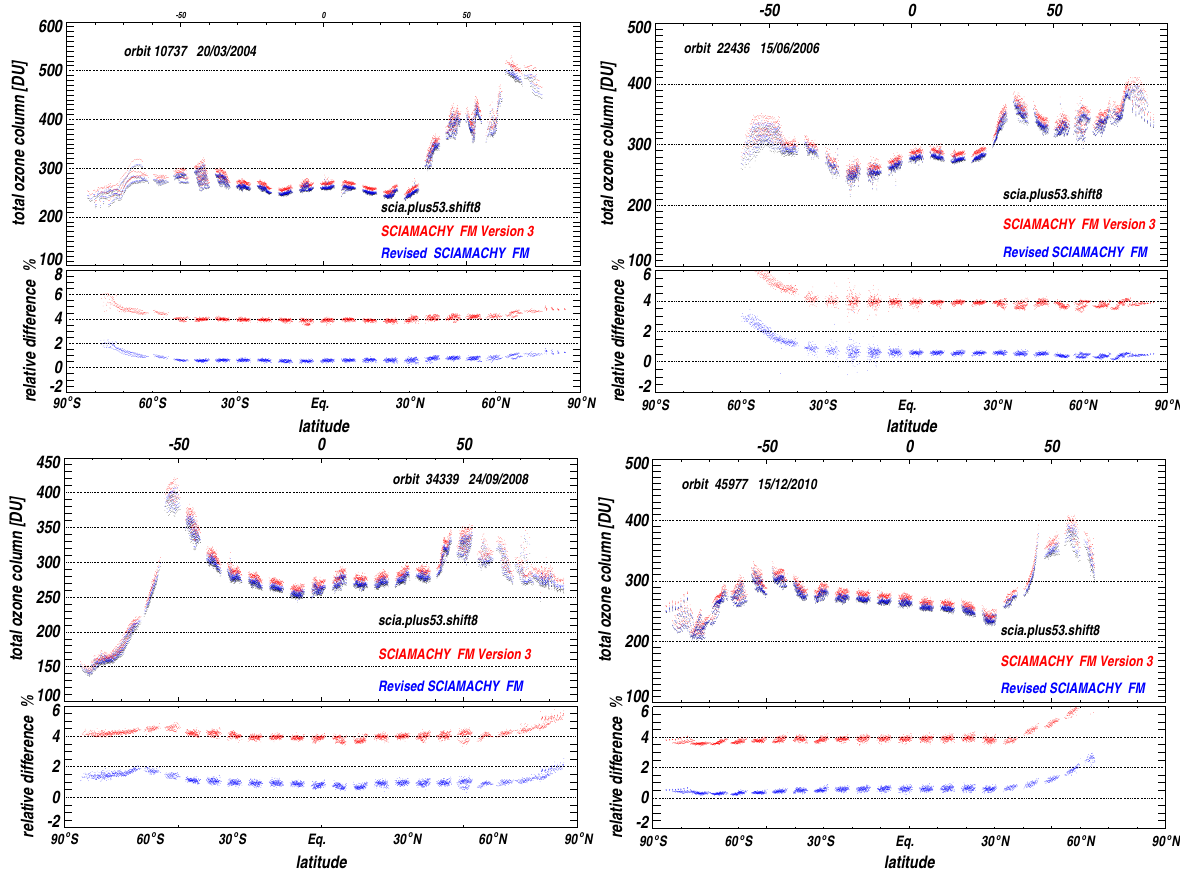
Fig. 13. SCIAMACHY’s total ozone column retrievals with different cross-section data for different season conditions over the lifetime of SCIAMACHY. Scia.plus53.shift8 is the SCIAMACHY FM data (Bogumil et al., 2003) with a differential scaling of +5.3% and shift of 0.08nm from a direct comparison to GOME FM cross sections (Weber et al., 2011) as used in the current standard retrieval. The lower sub-panels show the difference to the retrieved ozone using scia.plus53.shift8 cross sections.